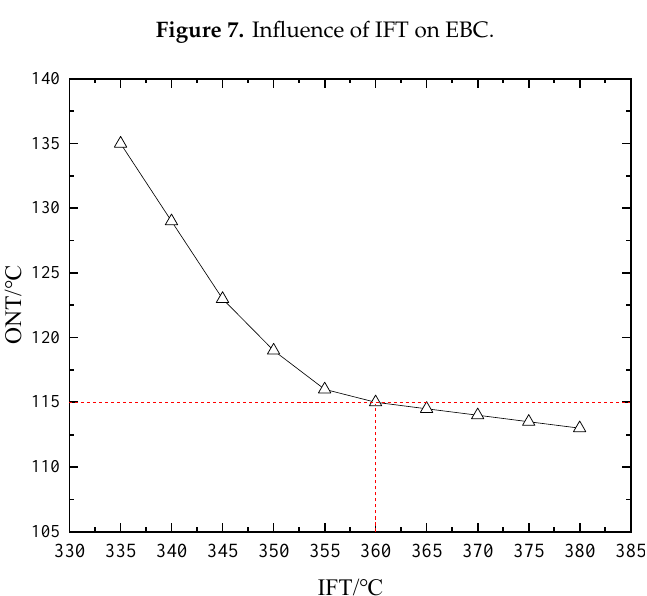
Figure 7. Influence of IFT on EBC.